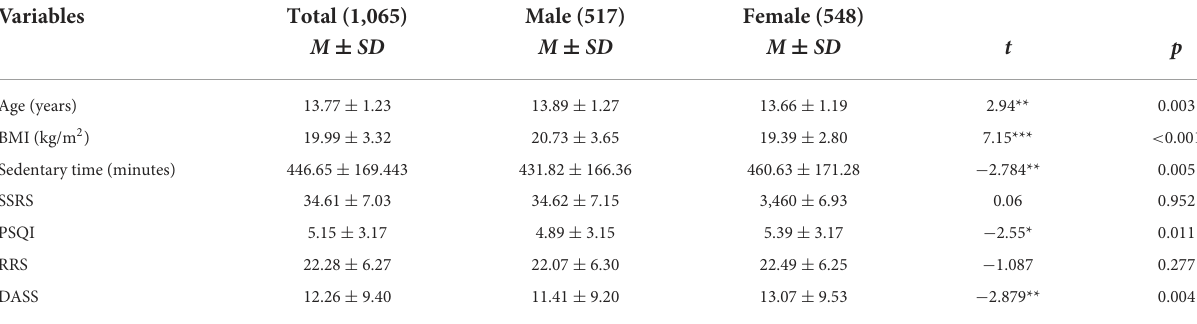
TABLE 1 Gender difference on sociodemographic and anthropometric variables.